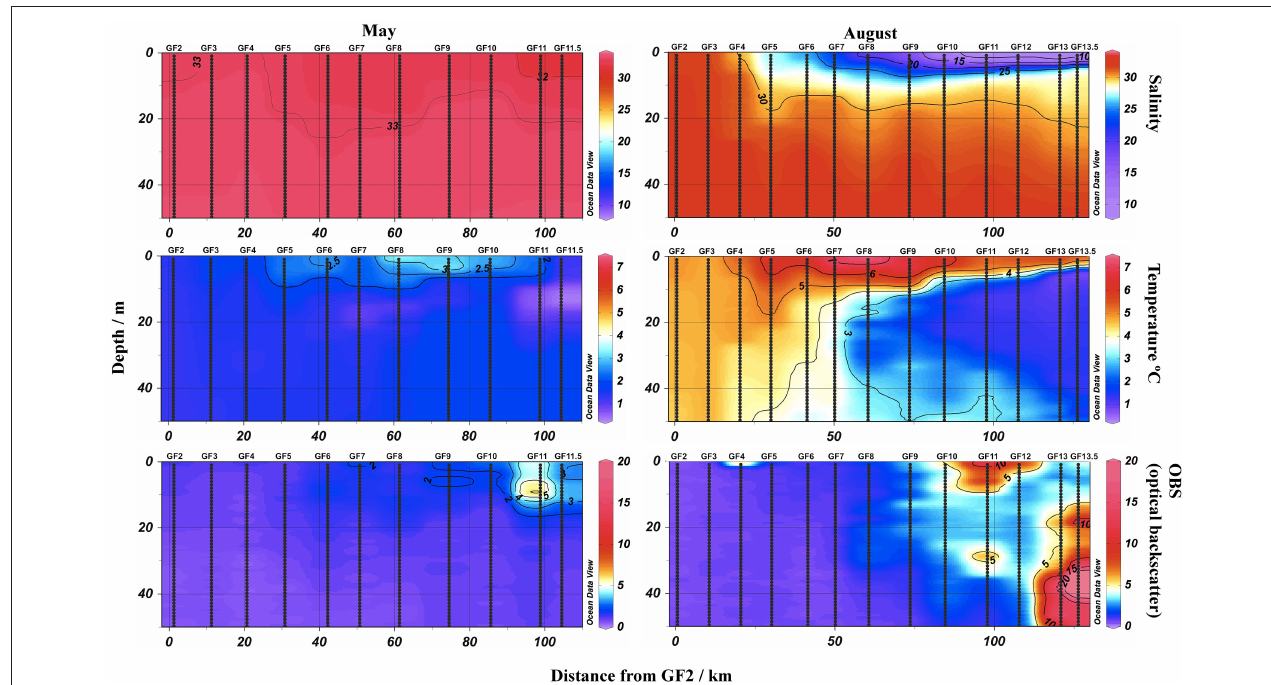
FIGURE 3 | Physical properties in the upper 50m of the water column within Godthåbsfjord in May (left) and August (right) 2014. Salinity (top), temperature ( ◦ C, middle) and turbidity (measured as optical backscatter, OBS, bottom). Sections plotted using Ocean Data View (Schlitzer, 2004) as distance away from GF2. Note the August transect proceeded further toward the Greenland Ice Sheet than the May transect due to reduced ice cover.